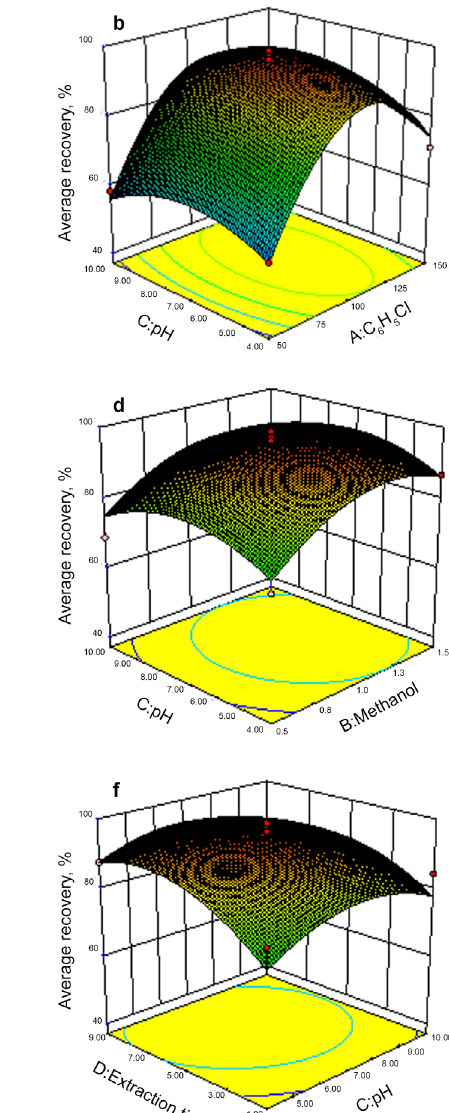
Fig. 3. Diagnostics of Eq.(4): a) predicted values versus actual experimental values of average recovery of OCPs and PCBs, b) plot of the residuals versus predicted values of average recovery.